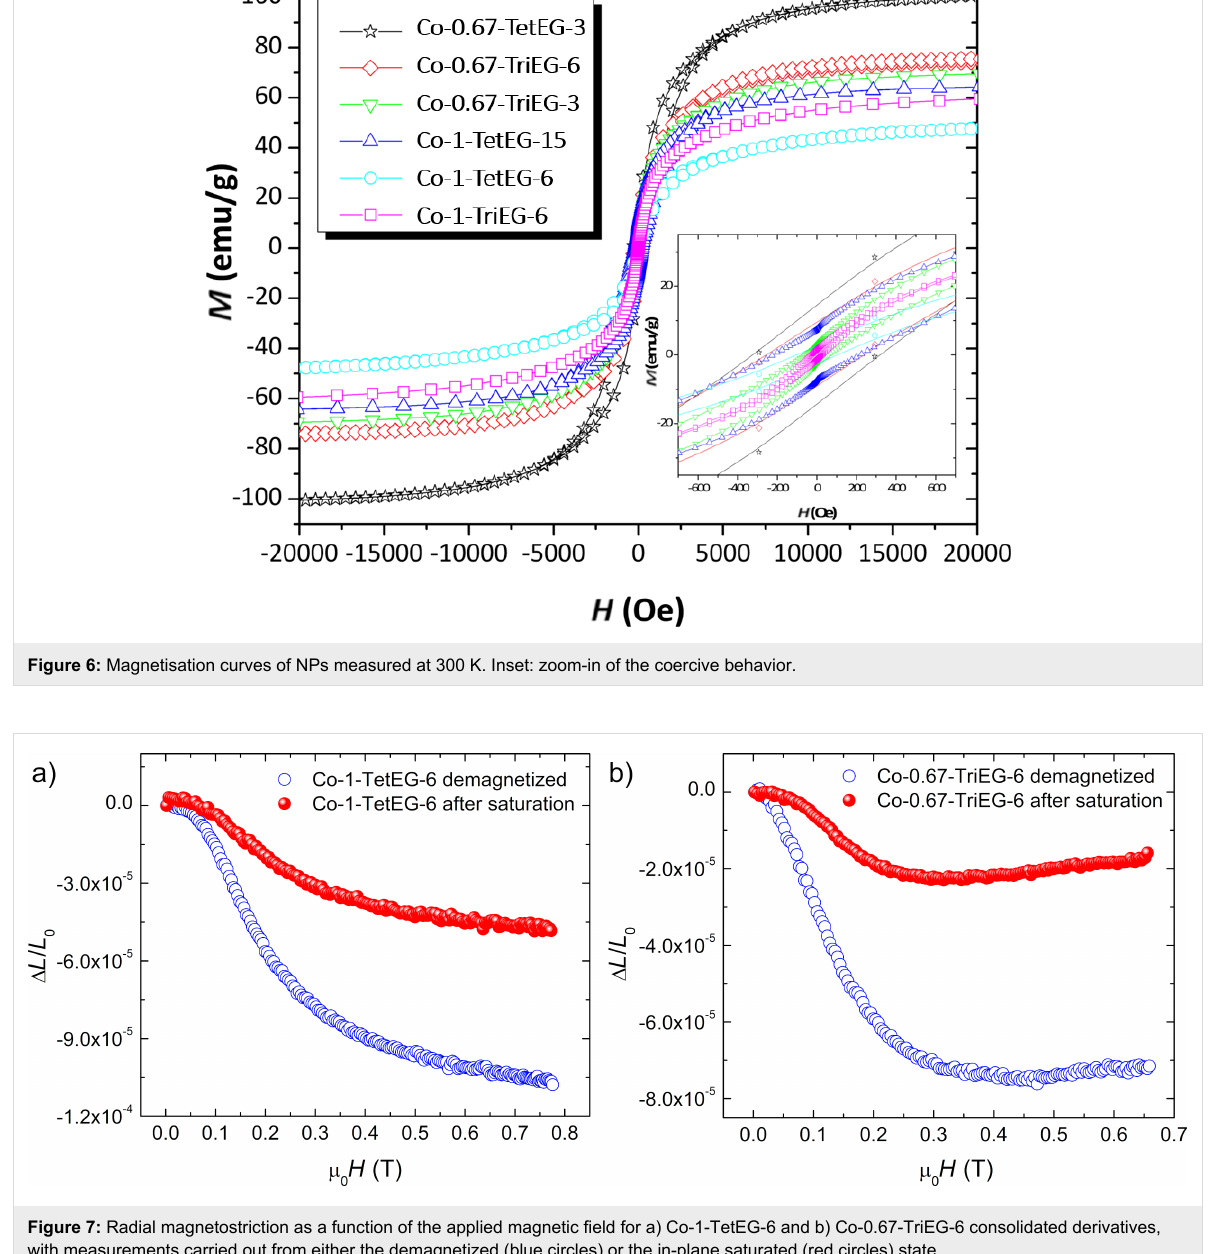
tization, a second measurement has been carried out showing a Δ L / L 0 coefficient strongly reduced to − 23 ppm due to the rema- nence effect of the magnetization. To recover the magnetostric- tion measured during the first cycle, it is necessary to prelimi- nary demagnetize the sample or to saturate the magnetization along a transversal